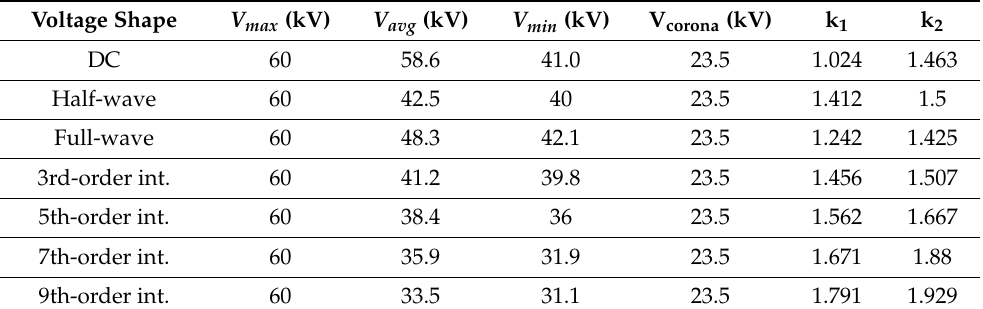
Table 2. The voltage values in the sections depend on the shape of voltage (Figure 4), without dust on the electrodes and a dust resistivity of 10 12 Ω ×